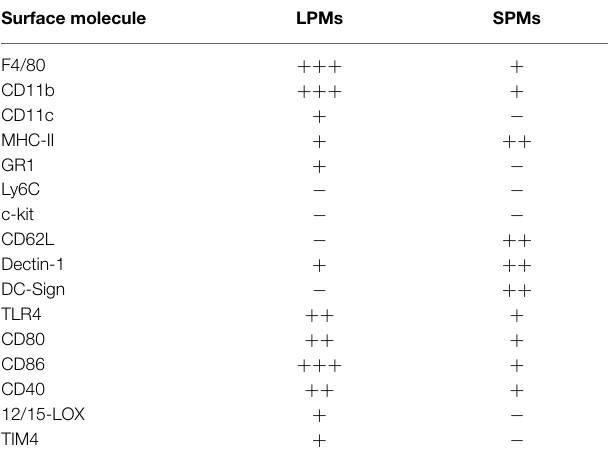
TABLE 1 | Phenotypic profile of SPMs and LPMs